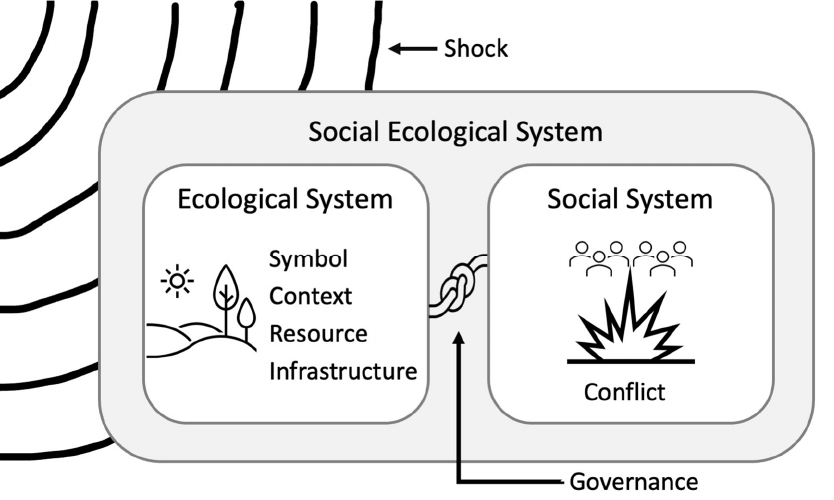
Figure 4. Shocks and conflict in social ecological systems. Shocks can affect ecological systems and social systems while conflicts pertain to the terrain of the social and therefore have a direct connection with social identity. Land can be understood as a symbol, a context, a resource and an infrastructure and shocks can alter some or all these different meanings. Reconstruction therefore should be understood in a physical, discursive, and material sense. Meaningful interactions between social and ecological systems can be establish through governance, non-coordinated interactions destabilize the social ecological system.